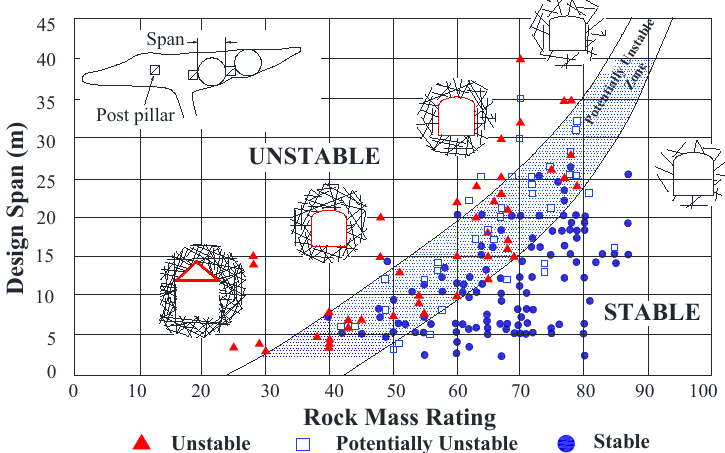
Figure 4. RMR critical span graph.